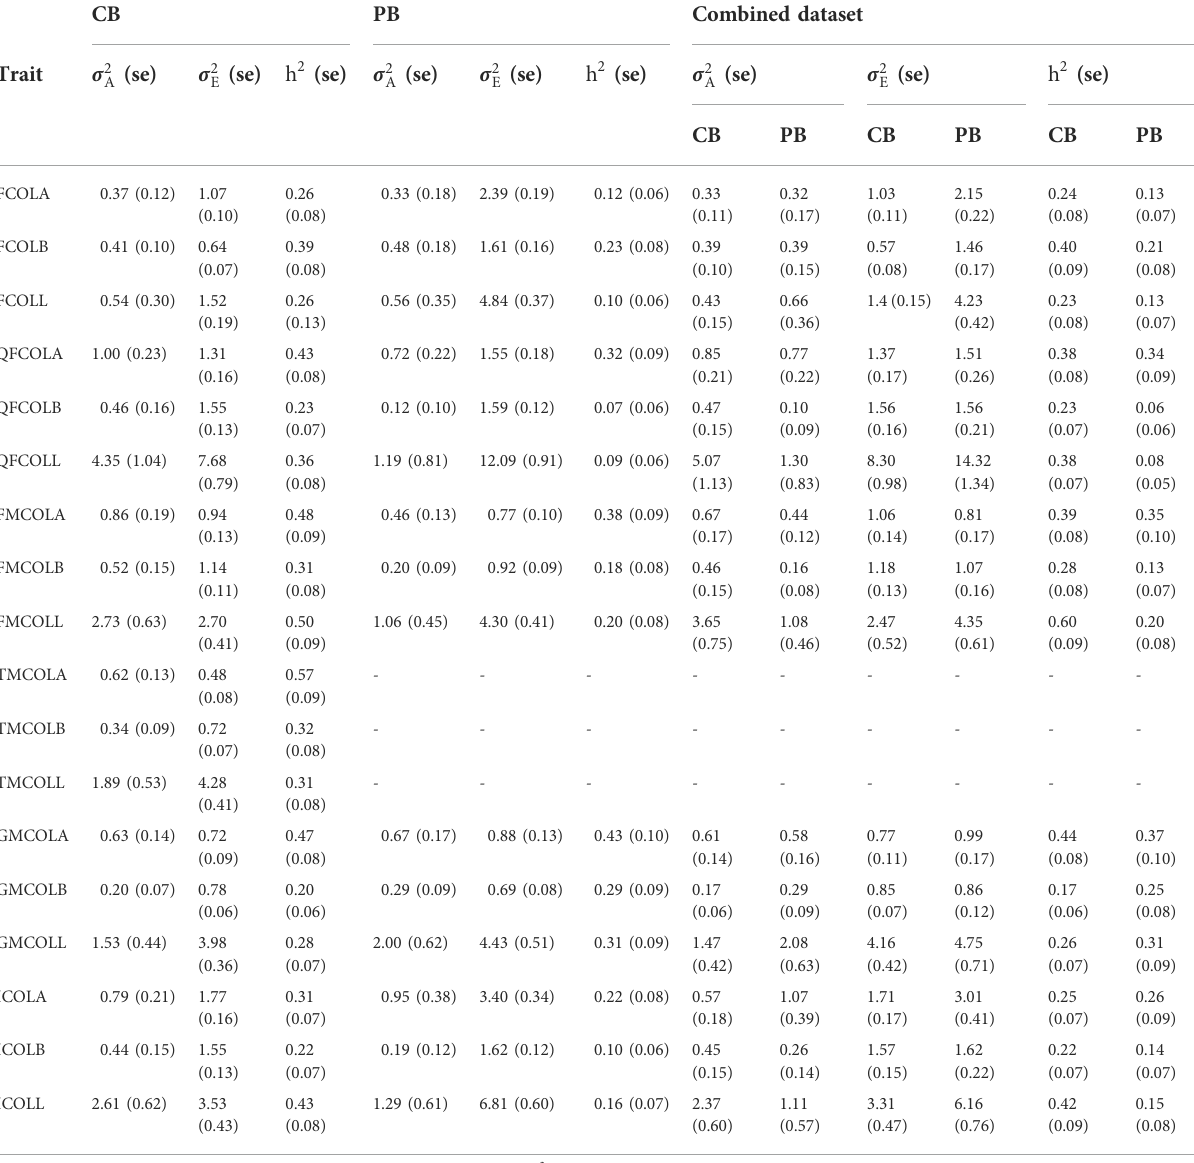
TABLE 6 Variance component estimates (additive and residual variances), and estimates of total heritability for 18 pork color traits for different datasets (CB, PB, and Combined